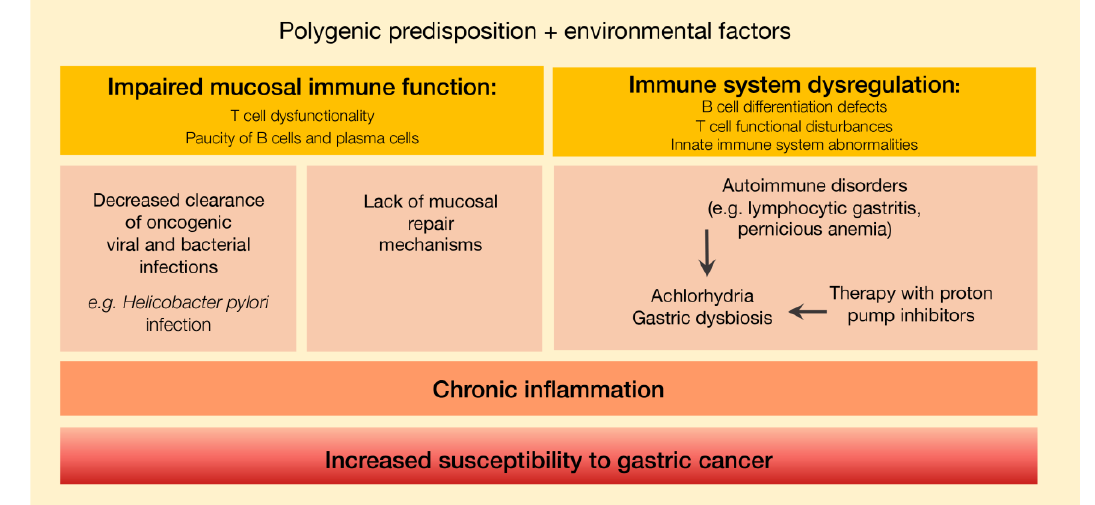
Figure 8. Defective immune environment in CVID and putative mechanisms leading to increased susceptibility to gastric cancer.